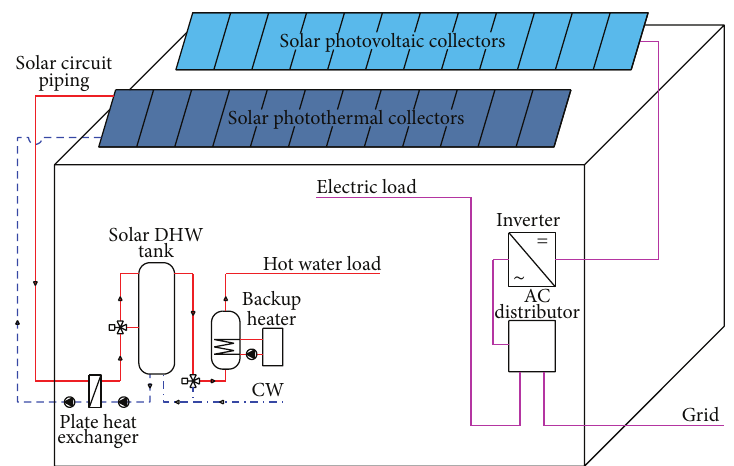
Figure 5: Simplified scheme of the considered solar energy system for block of